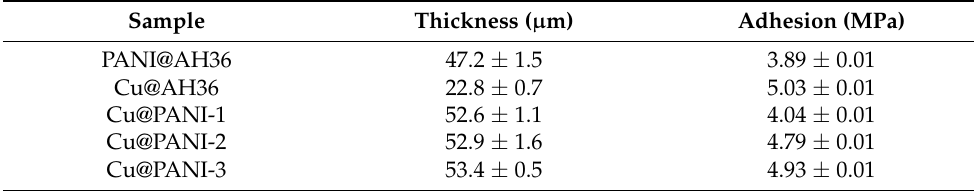
Figure 2. SEM images of ( a ) PANI@AH36, ( b ) Cu/PANI@AH36-1, ( c ) Cu/PANI@AH36-2, and ( d ) Cu/PANI@AH36-3. Table 1. The thickness and adhesion of the different